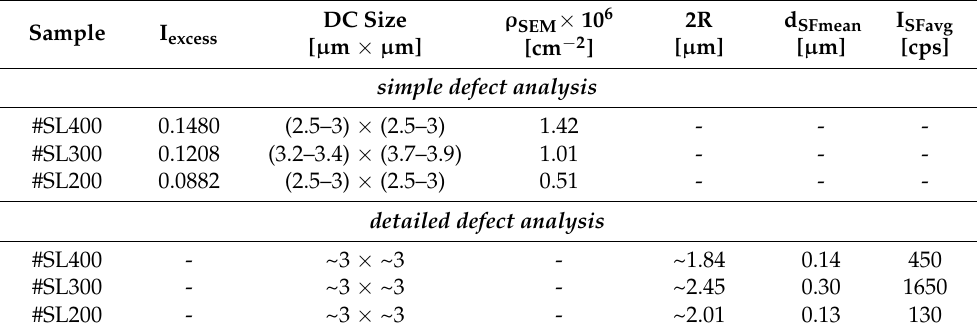
Table 1. The summary of simple and detailed defect analysis results. The values of I excess , 2R, d SFmean , and I SFavg were obtained using the HRXRD technique, the values of DC size and ρ SEM from SEM and TEM